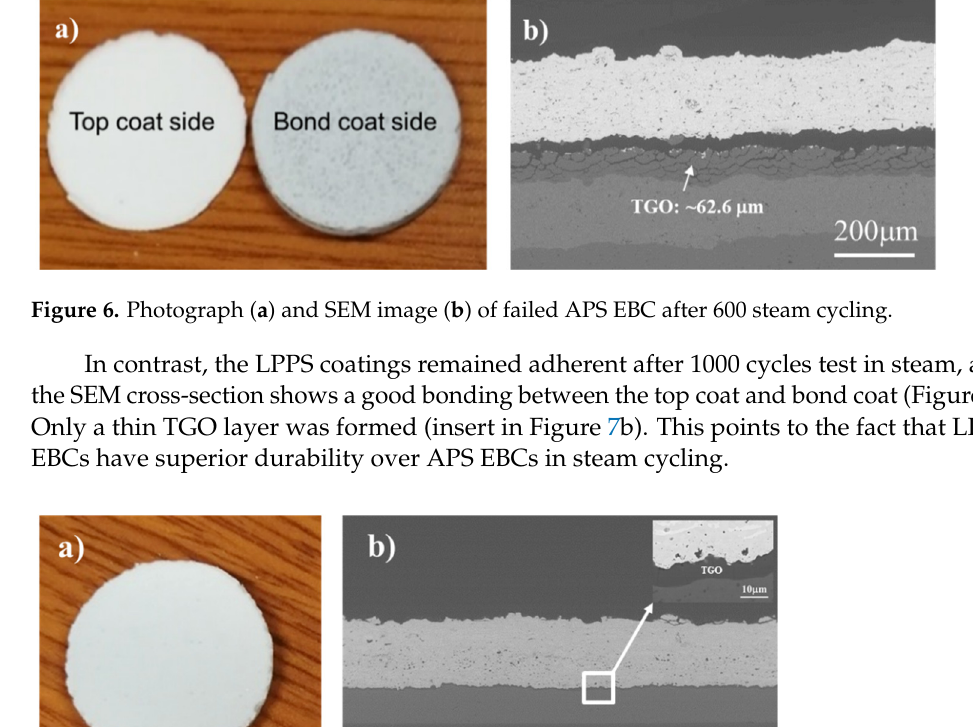
Figure 7. Photograph ( a ) and SEM image ( b ) of LPPS EBC after 1000 steam cycles (insert showing the high magnification of the TGO